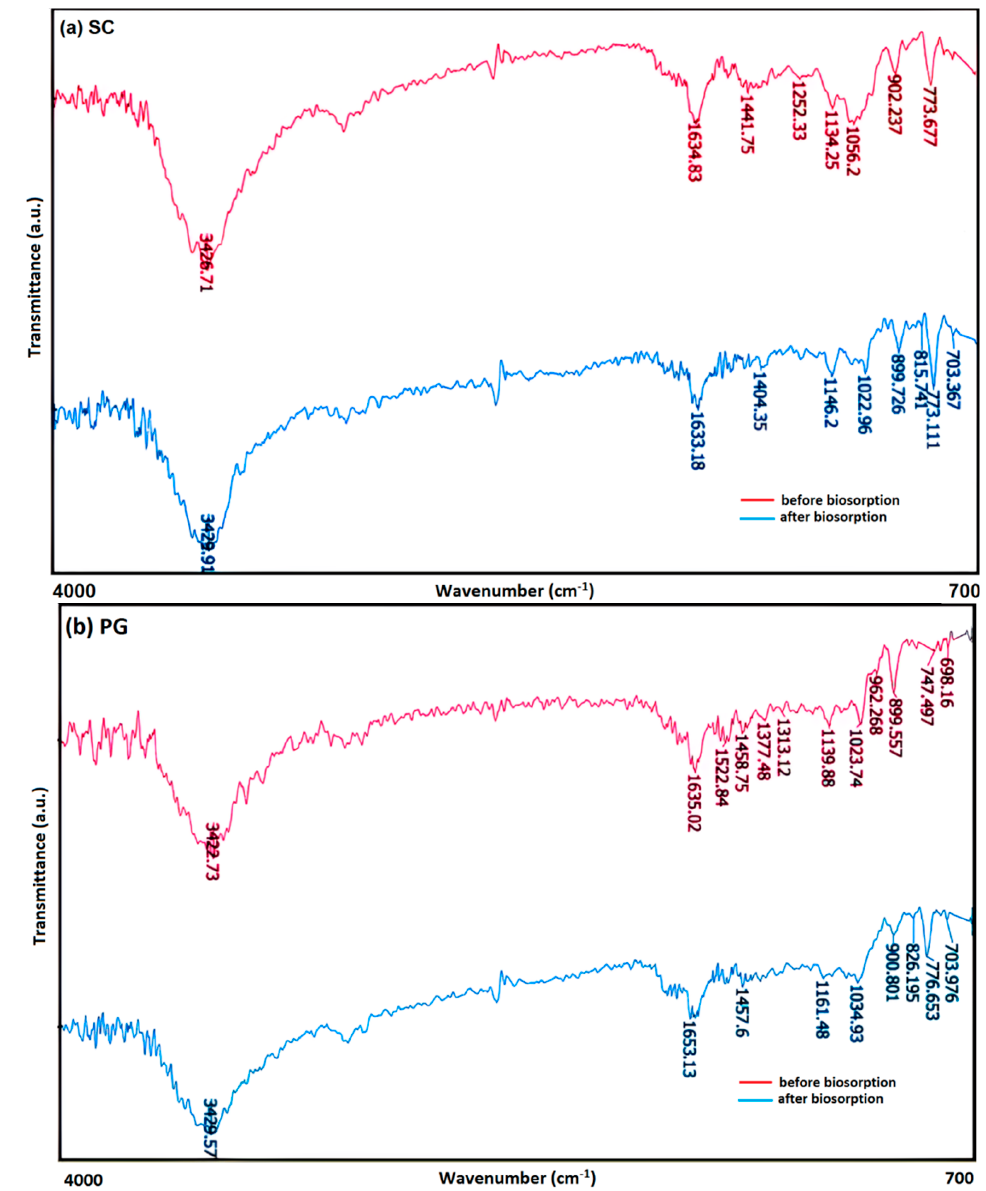
Figure 3. FTIR spectra: ( a ) SC and ( b ) PG before and after adsorption.